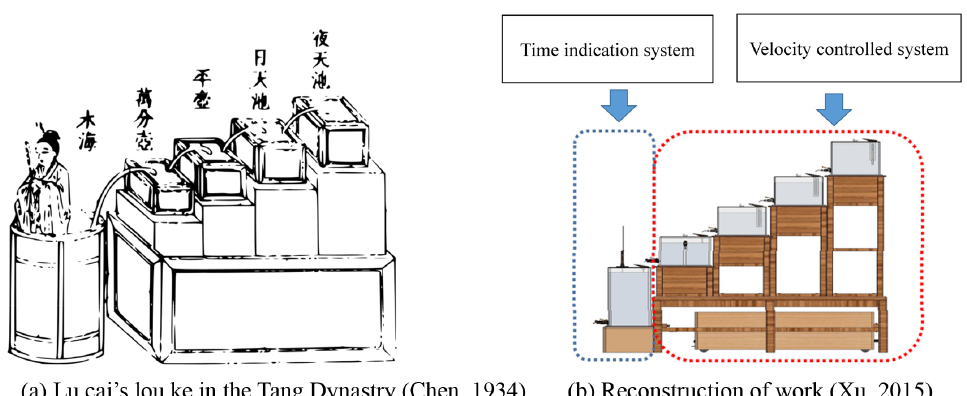
Figure 5. Time indication and speed control system of a multi-stage